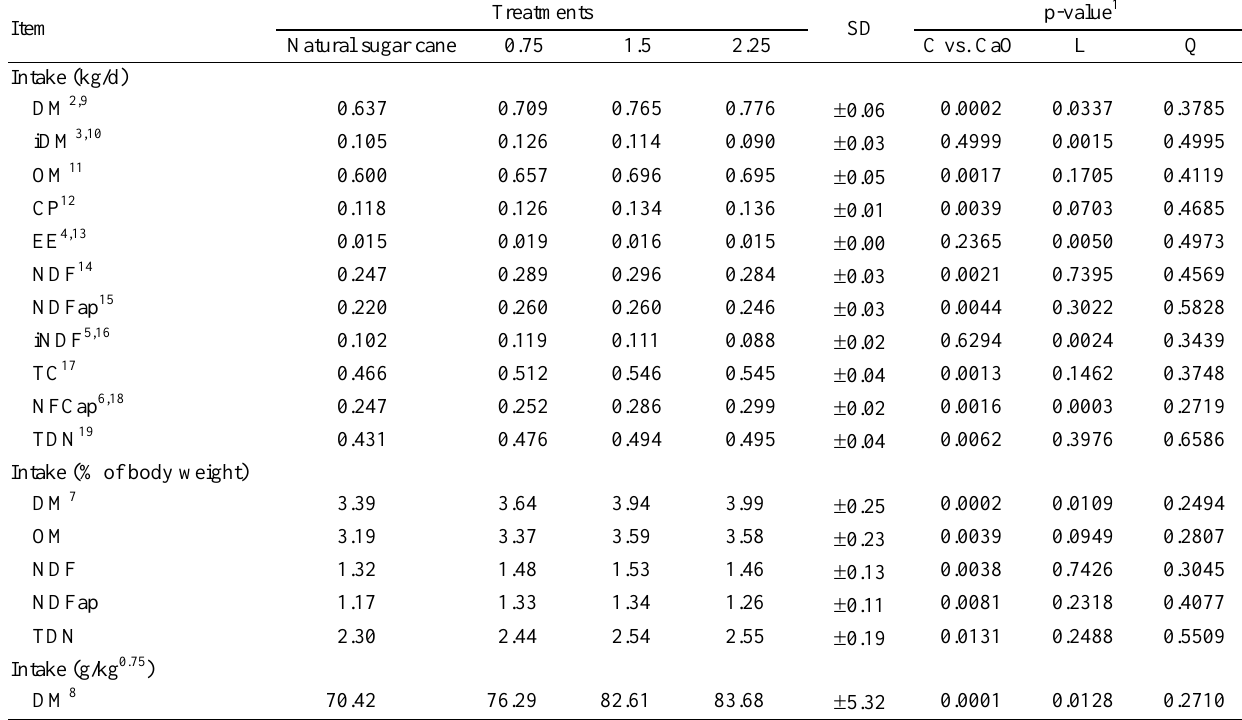
Table 4. Least square means, coefficient of variation (CV) and descriptive levels of probability contrasts (p-value) of dry matter